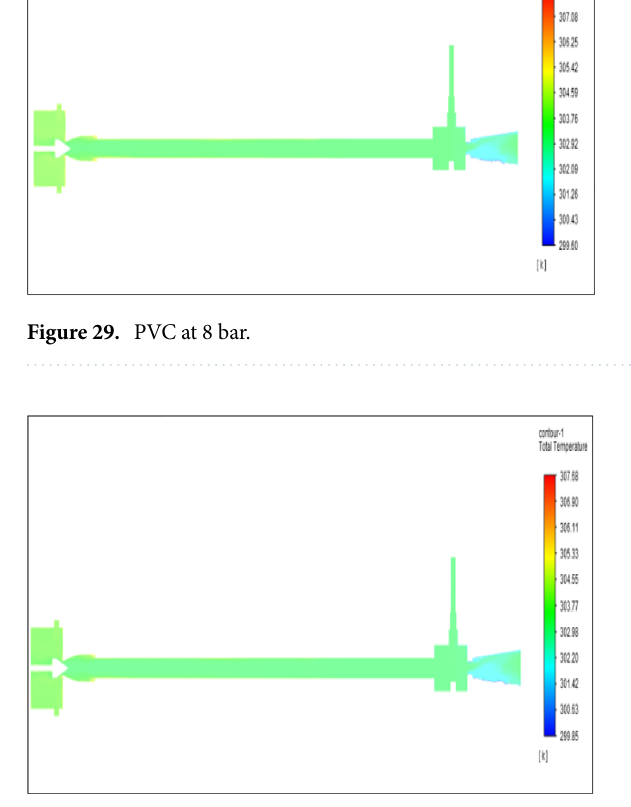
Figure 30. CPVC at 8 bar.